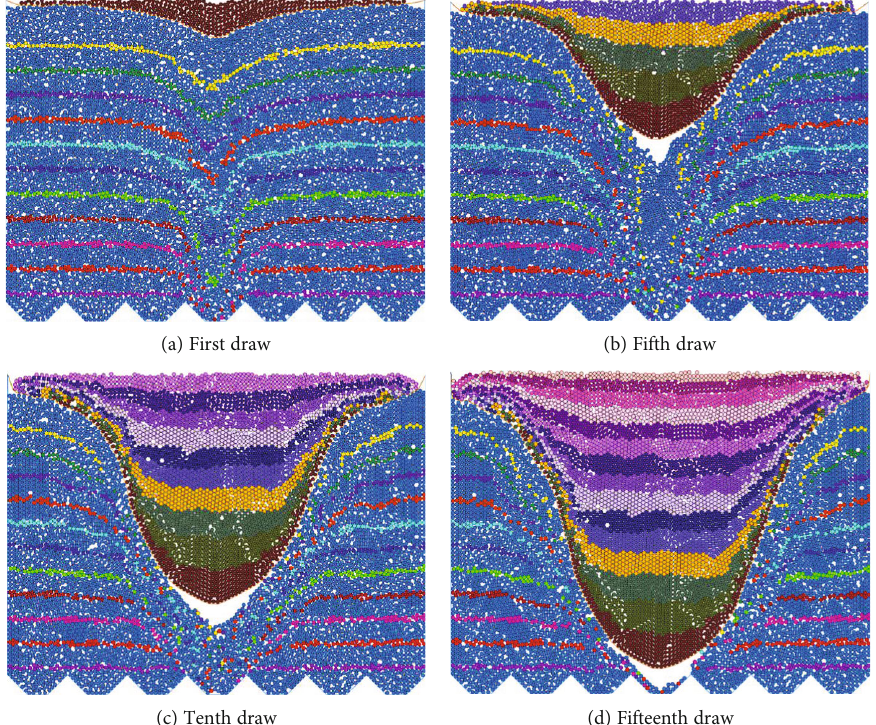
Figure 3: Macroscopic fl ow characteristics of ore particles during the ore